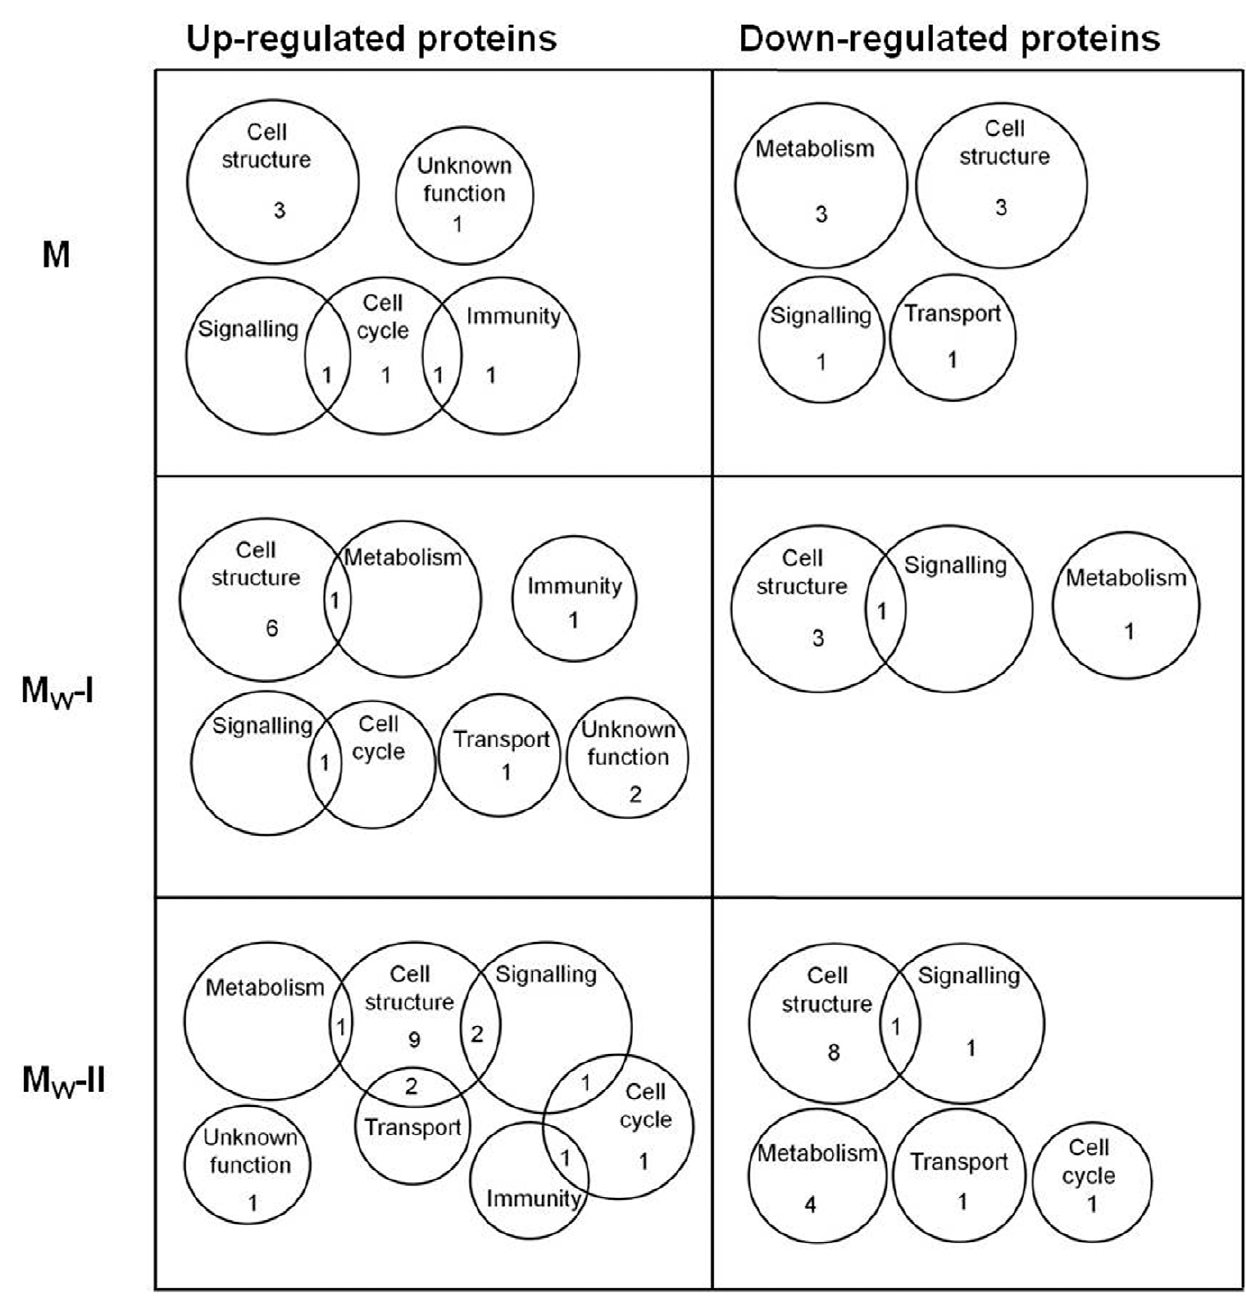
Figure 4. Venn diagrams showing the distribution of myocardial proteins in the plasma membrane-enriched fraction altered by morphine treatment and withdrawal. Numbers in the individual circles or sectors refer to the number of altered proteins which were determined in the PM-enriched fraction isolated from the left ventricles of morphine-treated (M) and morphine-withdrawn for 3 days (M W -I) or 6 days (M W -II) rats. These proteins were arranged according to their function into 16